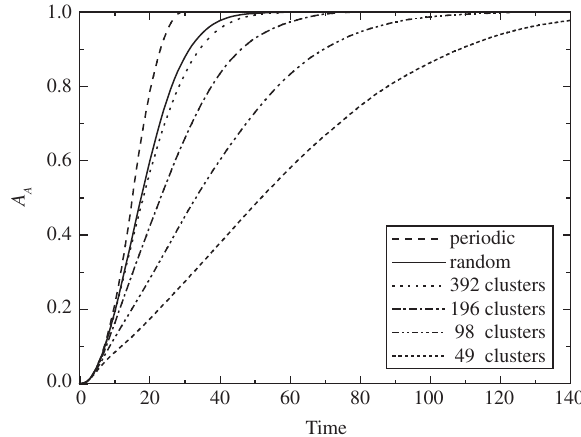
Figure 1. Area fraction against time, simulated by CA. The reaction is faster for a periodic nuclei arrangement and slower for clusters. The number of nuclei per unit of area is the same in all simulations.